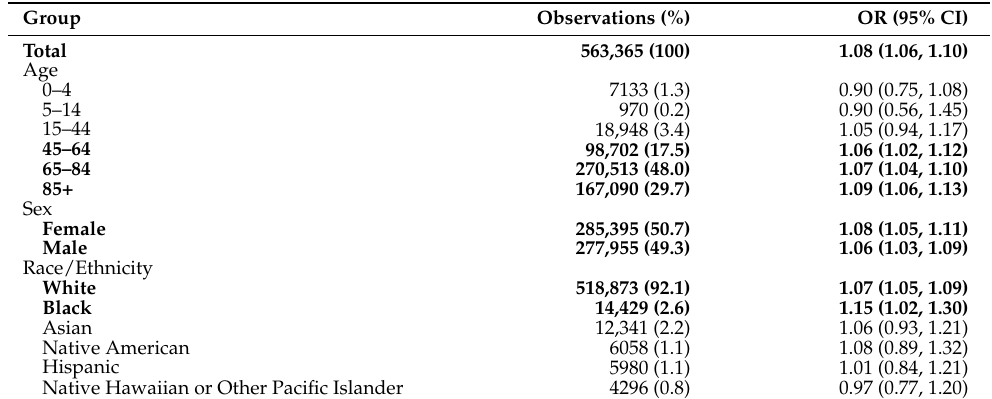
Table 3. Odds ratio (95% CI) of non-traumatic mortality comparing the 99th and 50th percentiles of humidex, by age group, sex, and